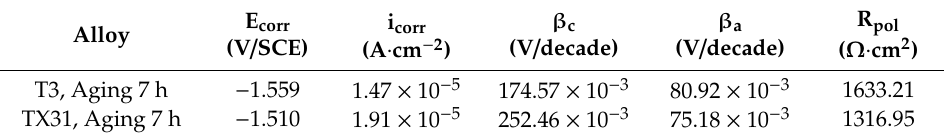
Table 2. Tafel fitting results of Mg-3Sn and Mg-3Sn-1Ca alloys for 7 h at 513 K in 3.5 wt.% NaCl solution. Alloy